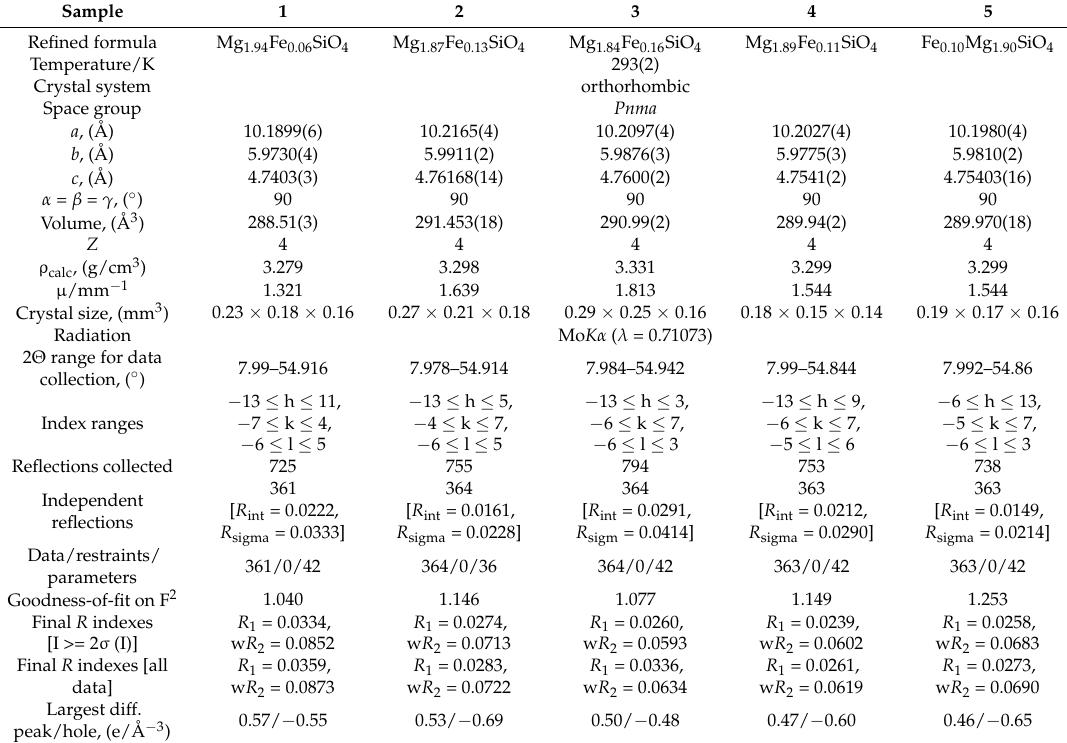
Table 6. Crystal data, data collection and structure refinement parameters of forsterite.